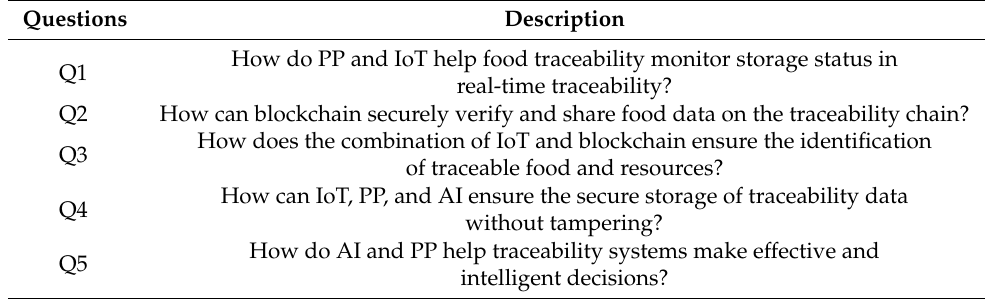
Table 6. Research